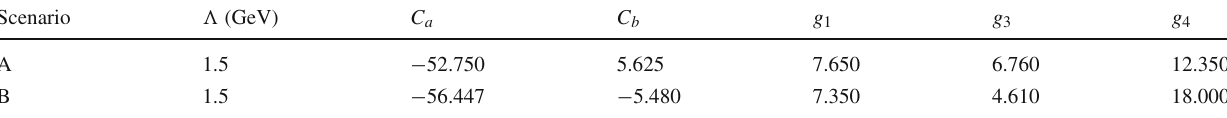
Table 2 Couplings of the contact-range potentials (in units of GeV − 1 ) for Scenario A and B obtained with a cutoff (cid:4) = 1 . 5 GeV Scenario